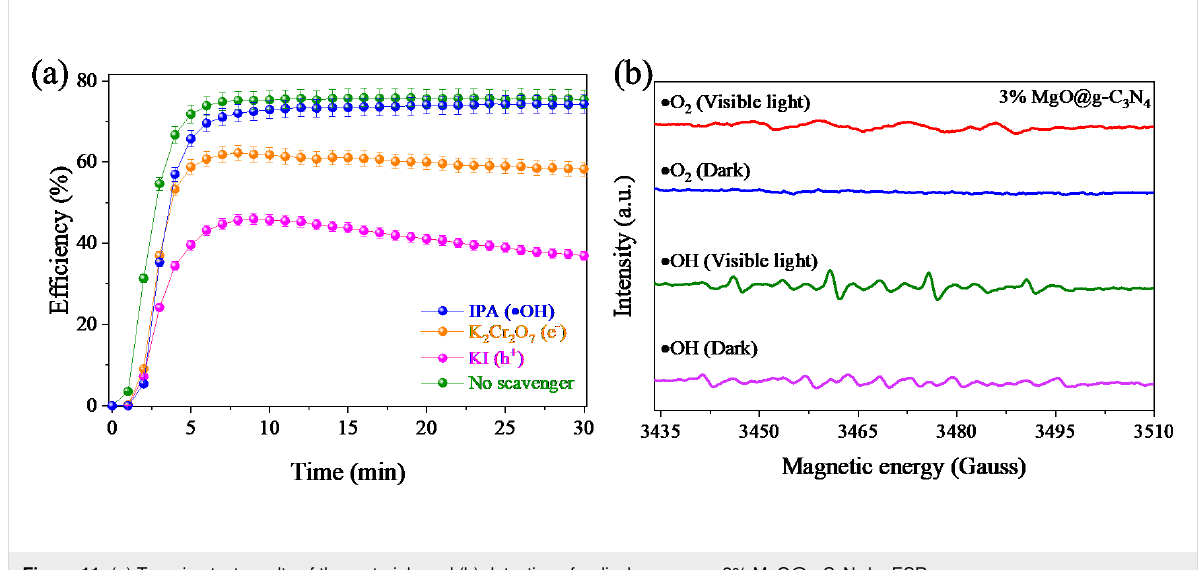
Figure 11: (a) Trapping test results of the materials and (b) detection of radicals over over 3% MgO@g-C 3 N 4 by ESR.